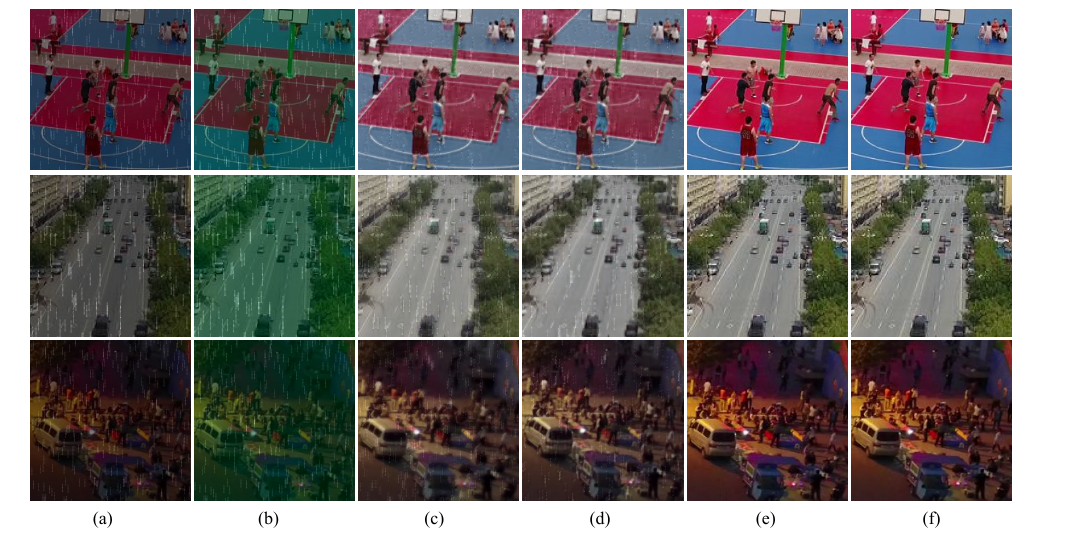
Figure 12. Visualization of the process of reconstructing rain-free patches with different epochs of training. Patches in Column ( a ) are the input rainy patches; patches in Columns ( b – e ) are the rain-free patches reconstructed by the proposed deraining model trained with 1, 50, 100, and 6000 epochs, respectively. Finally, patches in Column ( f ) are their corresponding ground